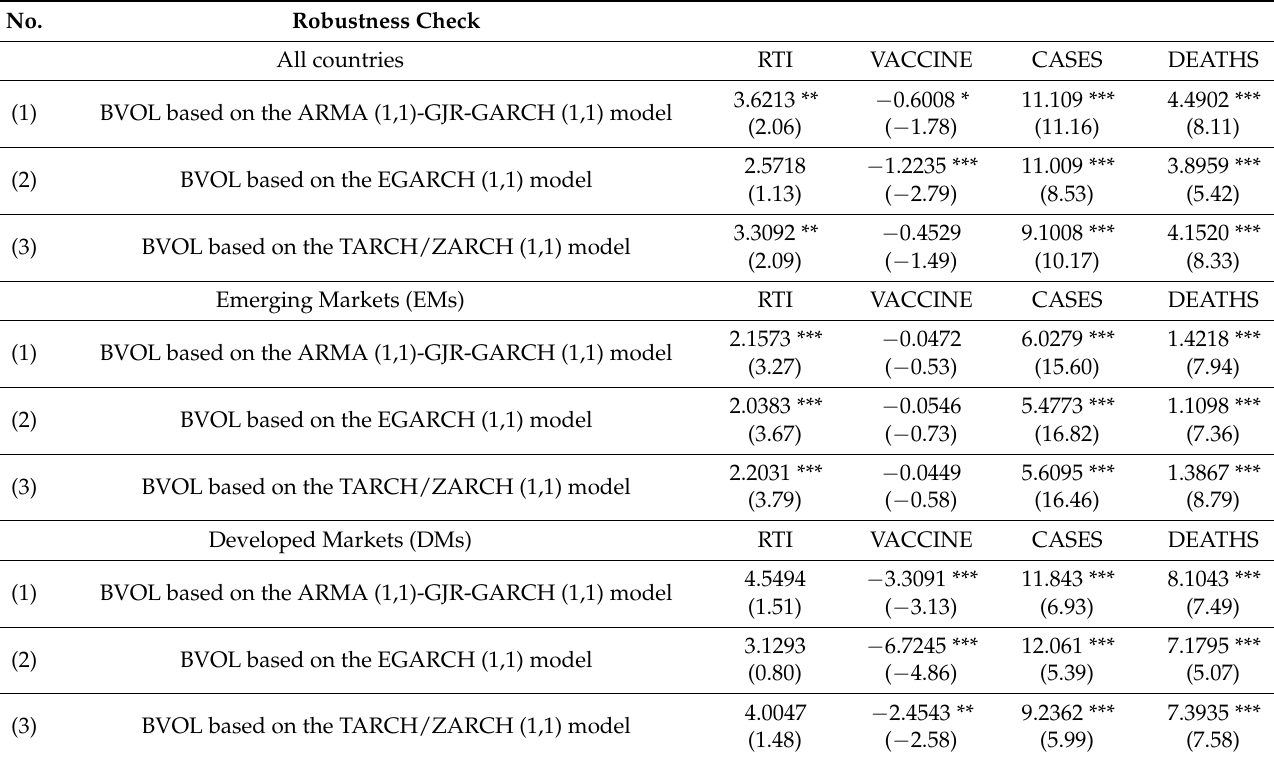
Table 4. Robustness tests—an alternative measure of forecasted models of conditional